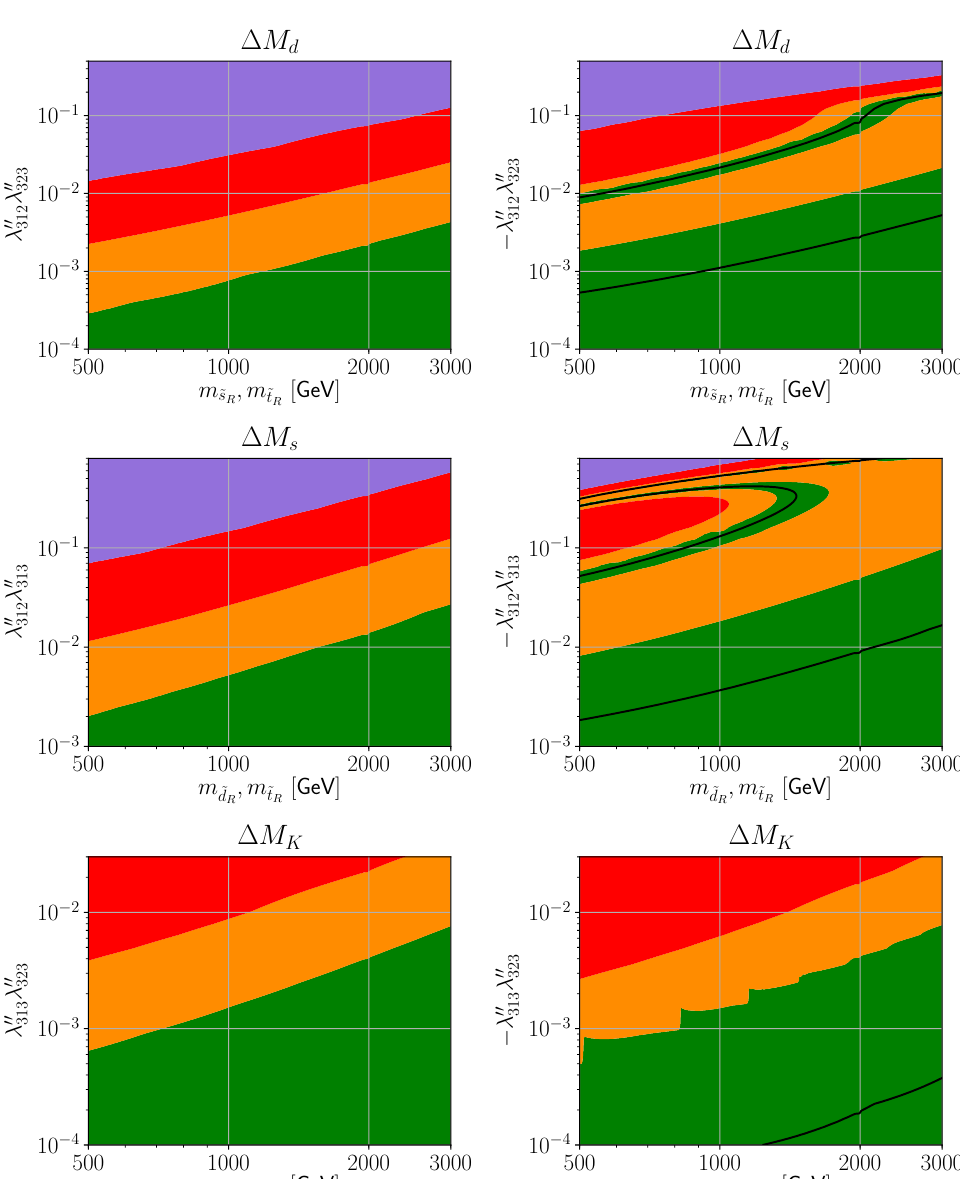
Figure 6. Limits on (cid:22) U 3 (cid:22) D i (cid:22) D j couplings from the meson oscillation parameters. Internal (s)top lines are allowed by such couplings. The color code is similar to that of the previous plots. For these plots, the parameter set of the scenario SUSY-RpV(a) of table 1 has been employed except for the squark masses that are scanned